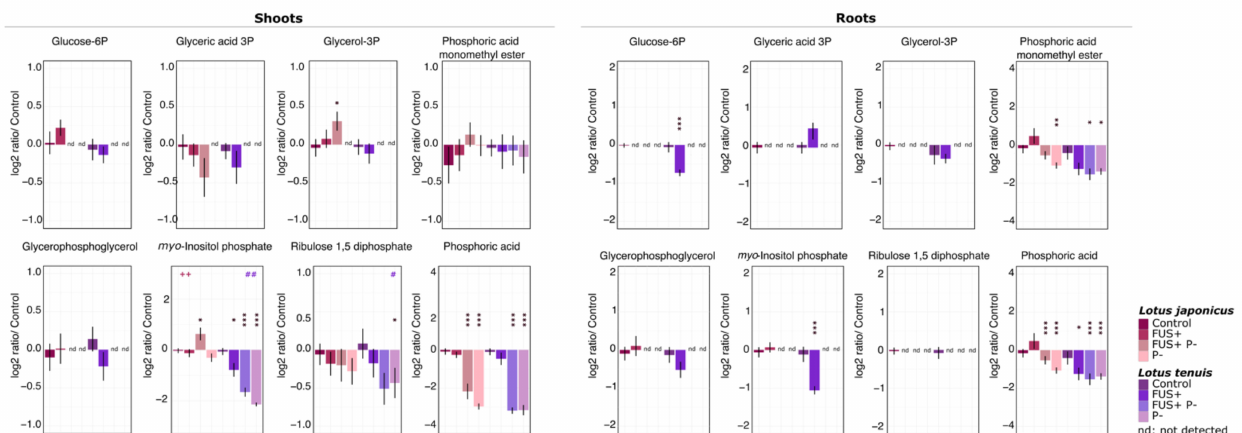
Figure 2. Log 2 relative concentration of phosphorylated metabolites detected in the shoots and roots of L. japonicus and L. tenuis after 32 days of treatment. Control (noninoculated—optimal Pi), FUS+ (inoculated—optimal Pi), P- (noninoculated— Pi starvation) and FUS+P- (inoculated—Pi starvation). Statistical differences between the control (noninoculated—optimal Pi) and each treatment (FUS+, P- and FUS+P-) were assessed using Student ´ s test (mean ± standard deviation, n = 10), * p < 0.05, ** p < 0.01, *** p < 0.001, nd: not detected. Two-way ANOVA results of the interaction FUS+P- ; ++ p < 0.01 for L. japonicus ; # p < 0.05 and ## p < 0.01 for L. tenuis